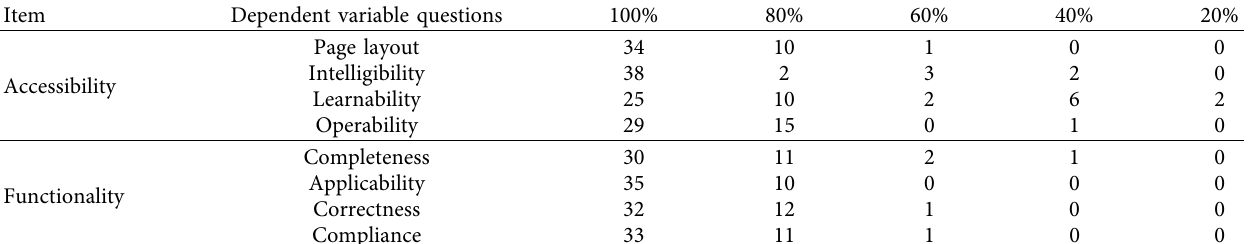
Table 16: Questionnaire feedback of intelligence platform.